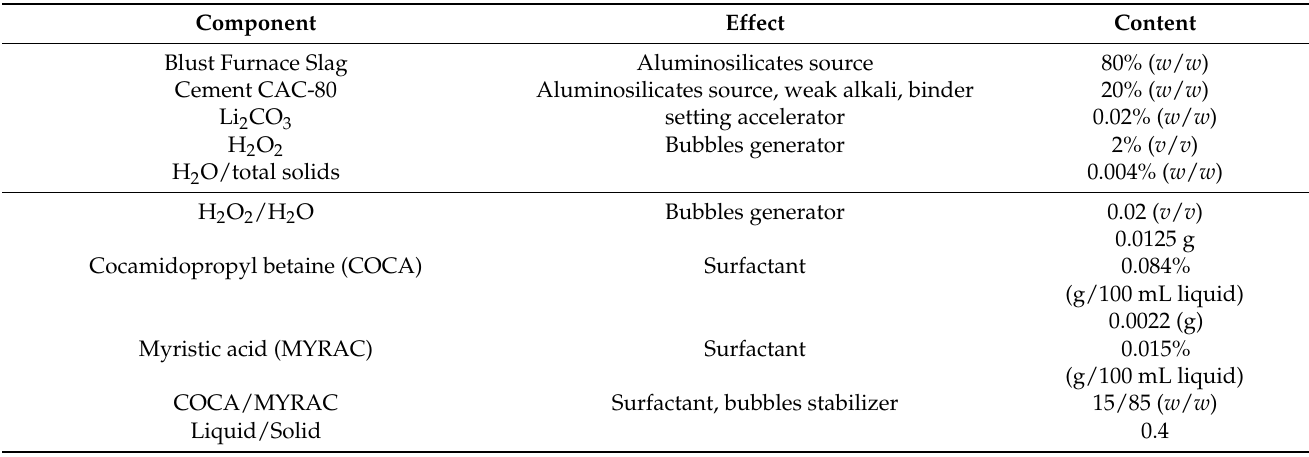
Table 2. Formulation used in the porous monolith